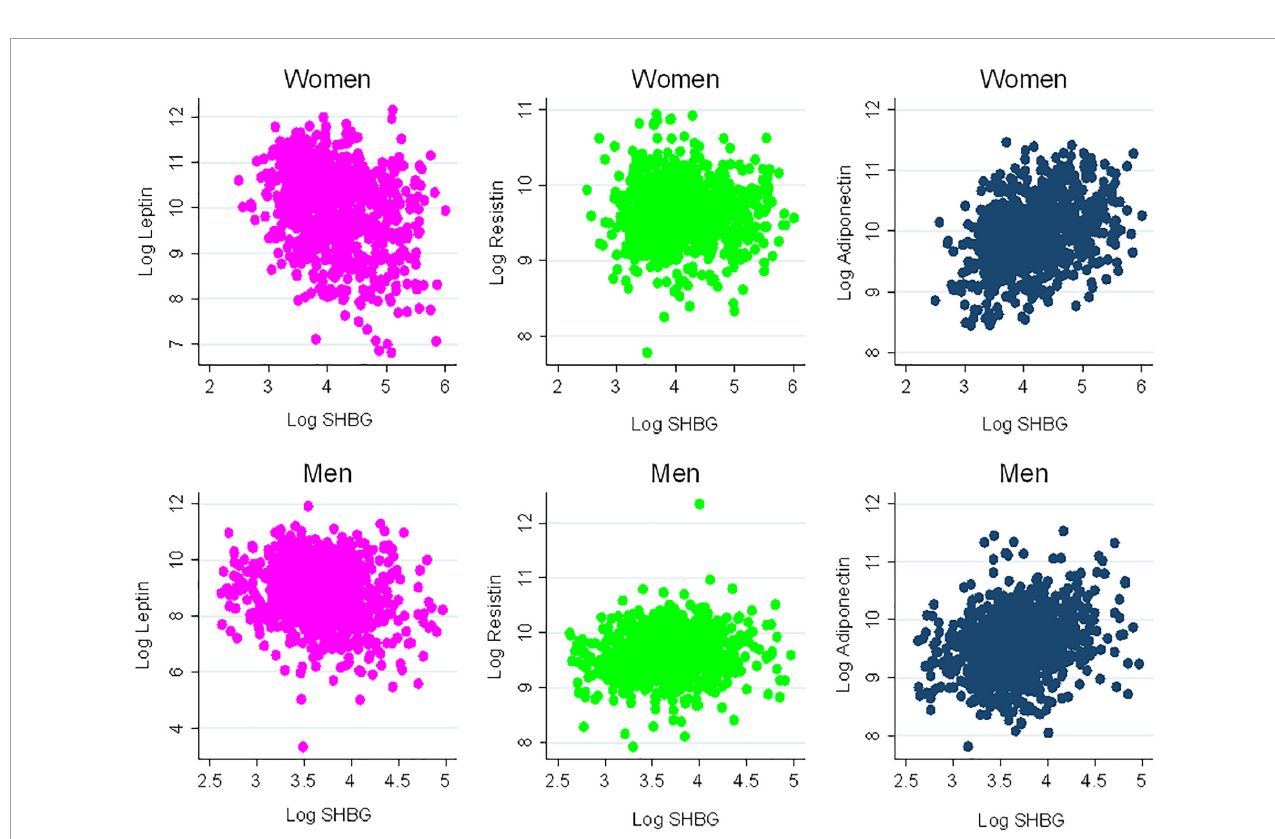
FIGURE3 Scatterplots of adipokines vs. sex hormone binding globulin. SHBG, sex hormone binding